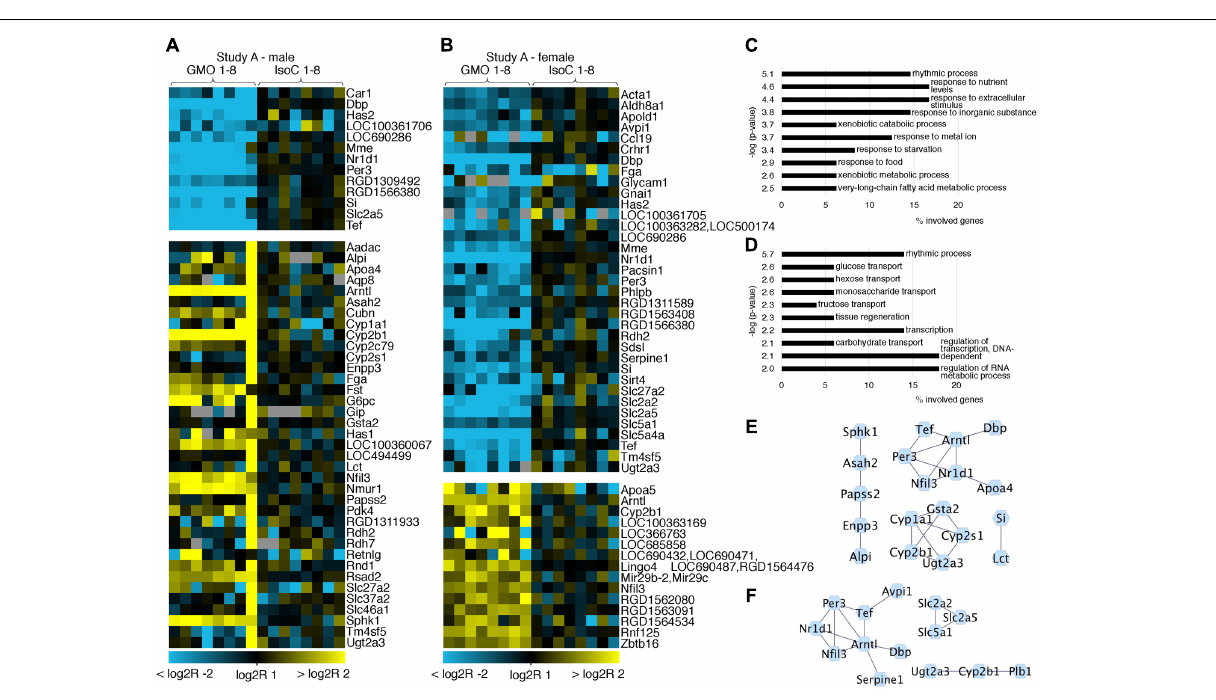
FIGURE 2 | Heatmap of differentially expressed genes and gene ontology (GO) analysis. Heatmaps showing the top 50 differentially expressed genes with more than twofold up- or down-regulation ( q < 0.05) in male (A) and female (B) animals of study A. GO analysis of the differentially expressed genes (log2R > 1 or < –1) indicates pathways in which regulated genes show a highly significant enrichment in males (C) or females (D) . Networks of protein-protein interactions of males (E) or females (F) using STRING demonstrate associations in sets of differentially expressed